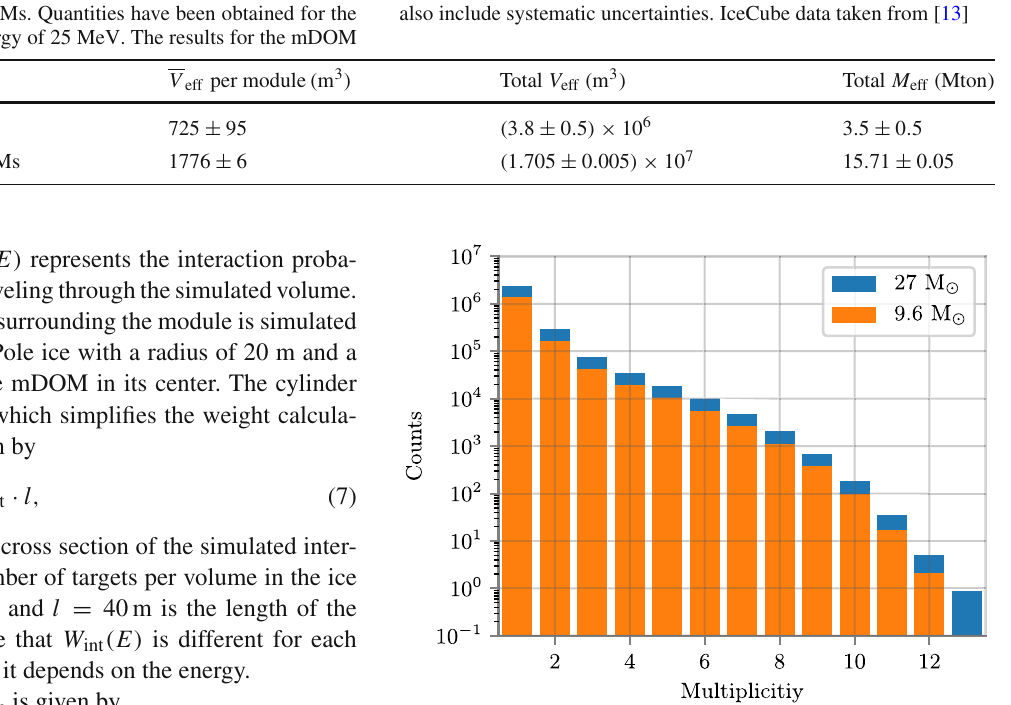
detector include statistical uncertainties only, while the IceCube results also include systematic uncertainties. IceCube data taken from [13]